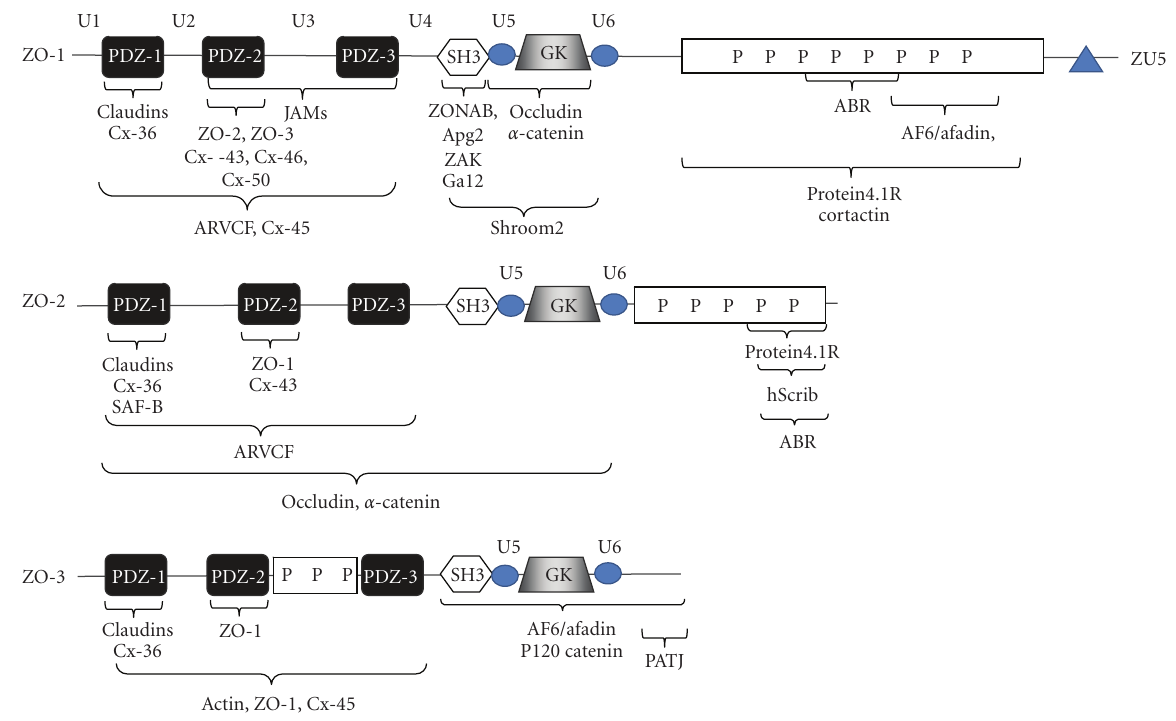
Figure 2: ZO proteins interact with transmembrane proteins and with peripheral cytoplasmic proteins at the junctional site. Details are mentioned in the text. Some proteins interacting with ZO proteins are not included in the figure since their association domain is less well described. These include CAR (coxsackievirus and adenovirus receptor), tricellulin, and cingulin. ABR: actin binding region; AF-6: ALL-1 fusion partner at chromosome 6; Apg-2: (ATP and peptide-binding protein in germ cells)-2; Cx: Connexin; Ga12: G protein α 12 subunit; GUK: Guanylate kinase-like domain; JAM: Junction adhesion molecule; hScrib: human Scribble; PATJ: Protein associated with tight junctions; P-P-P: Proline-rich region; PDZ: Psd95/discs large/zonula occludens-1 domain; SAF-B: Sca ff old attachment factor-B; SH3: Src homology3 domain; U1-U6: Unique variable domains; ZAK: ZO-1 associated kinase; ZONAB: ZO-1 associated nucleic acid binding protein; ZU5: Domain present in ZO-1 and Unc5-like netrin